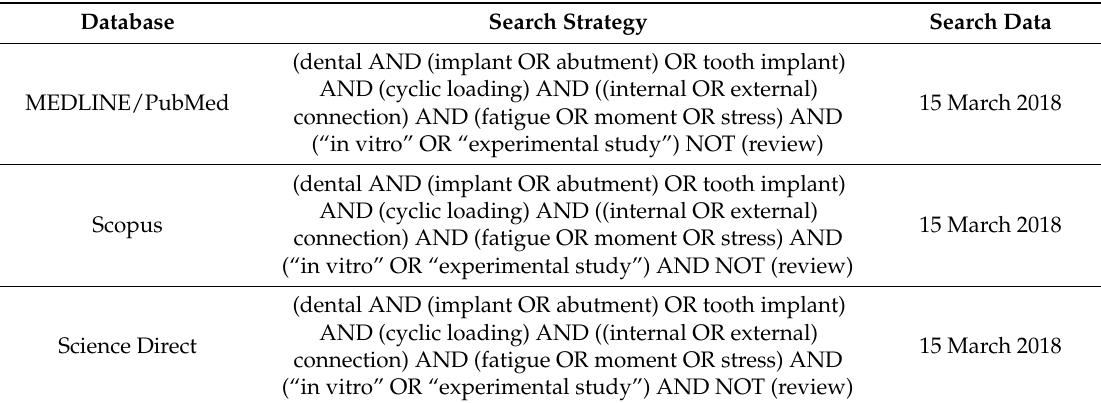
Table 1. Search strategies carried out in